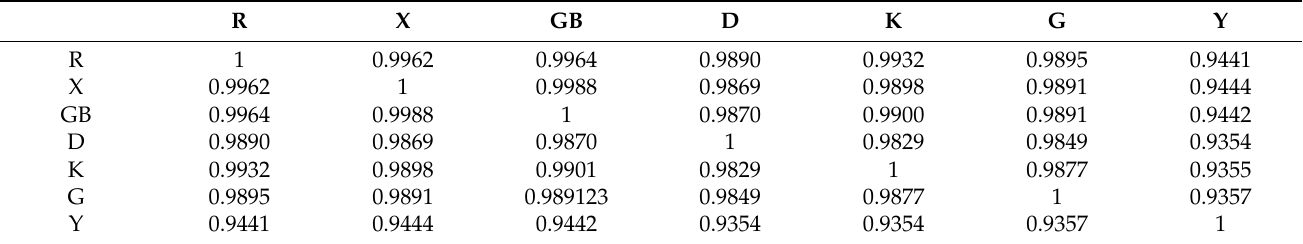
Table 3. The Pearson coefficient analysis table.